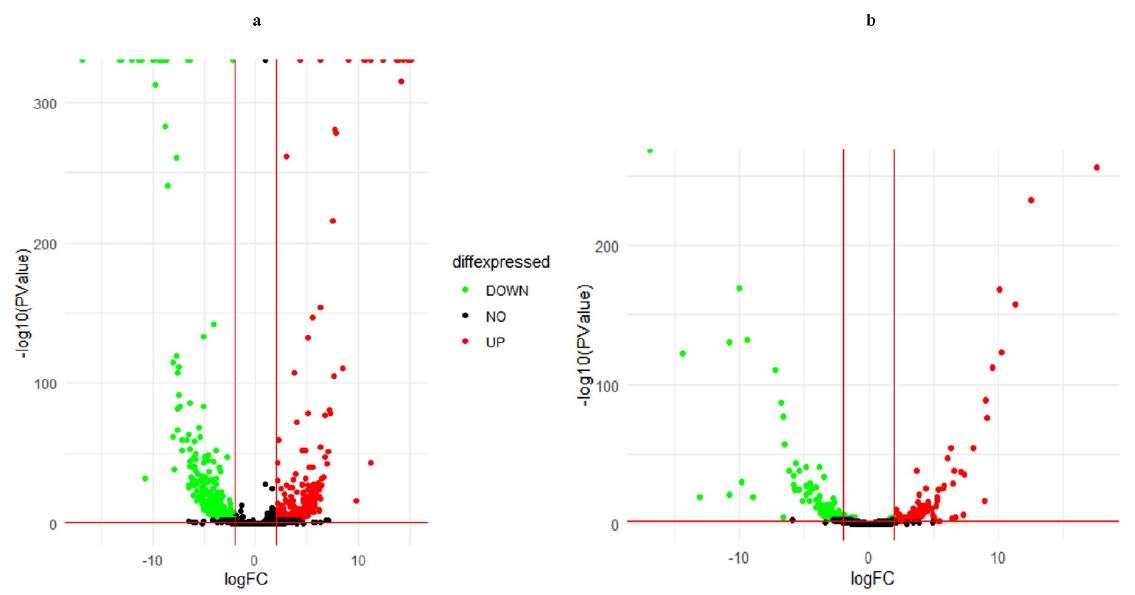
Figure 3. Volcano plot of differentially expressed genes ( a ) galphimine producer plants (leaves samples) versus non ‐ galphimine producer plants (leaves samples) ( b ) galphimine producer plants (leaves samples) versus control (roots samples). X ‐ axis and y ‐ axis represent log2 fold ‐ change differences between the compared samples and statistical significance as the negative log of differentially expressed genes p -values, respectively. The significantly up-regulated and down-regulated genes are indicated with red and green dots, respectively, while non-significant genes are shown as black